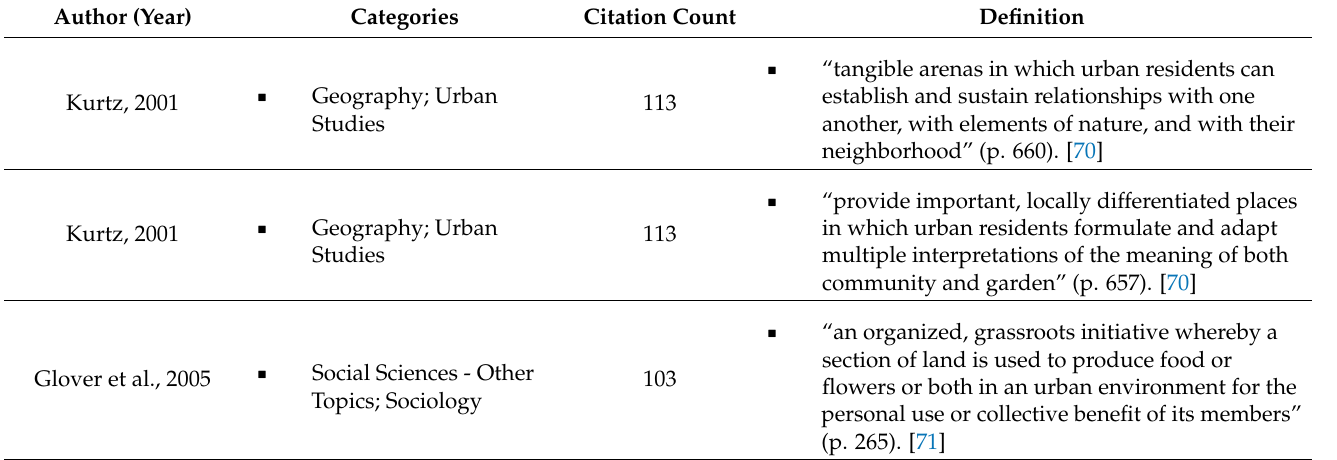
Table 2. Definitions of community